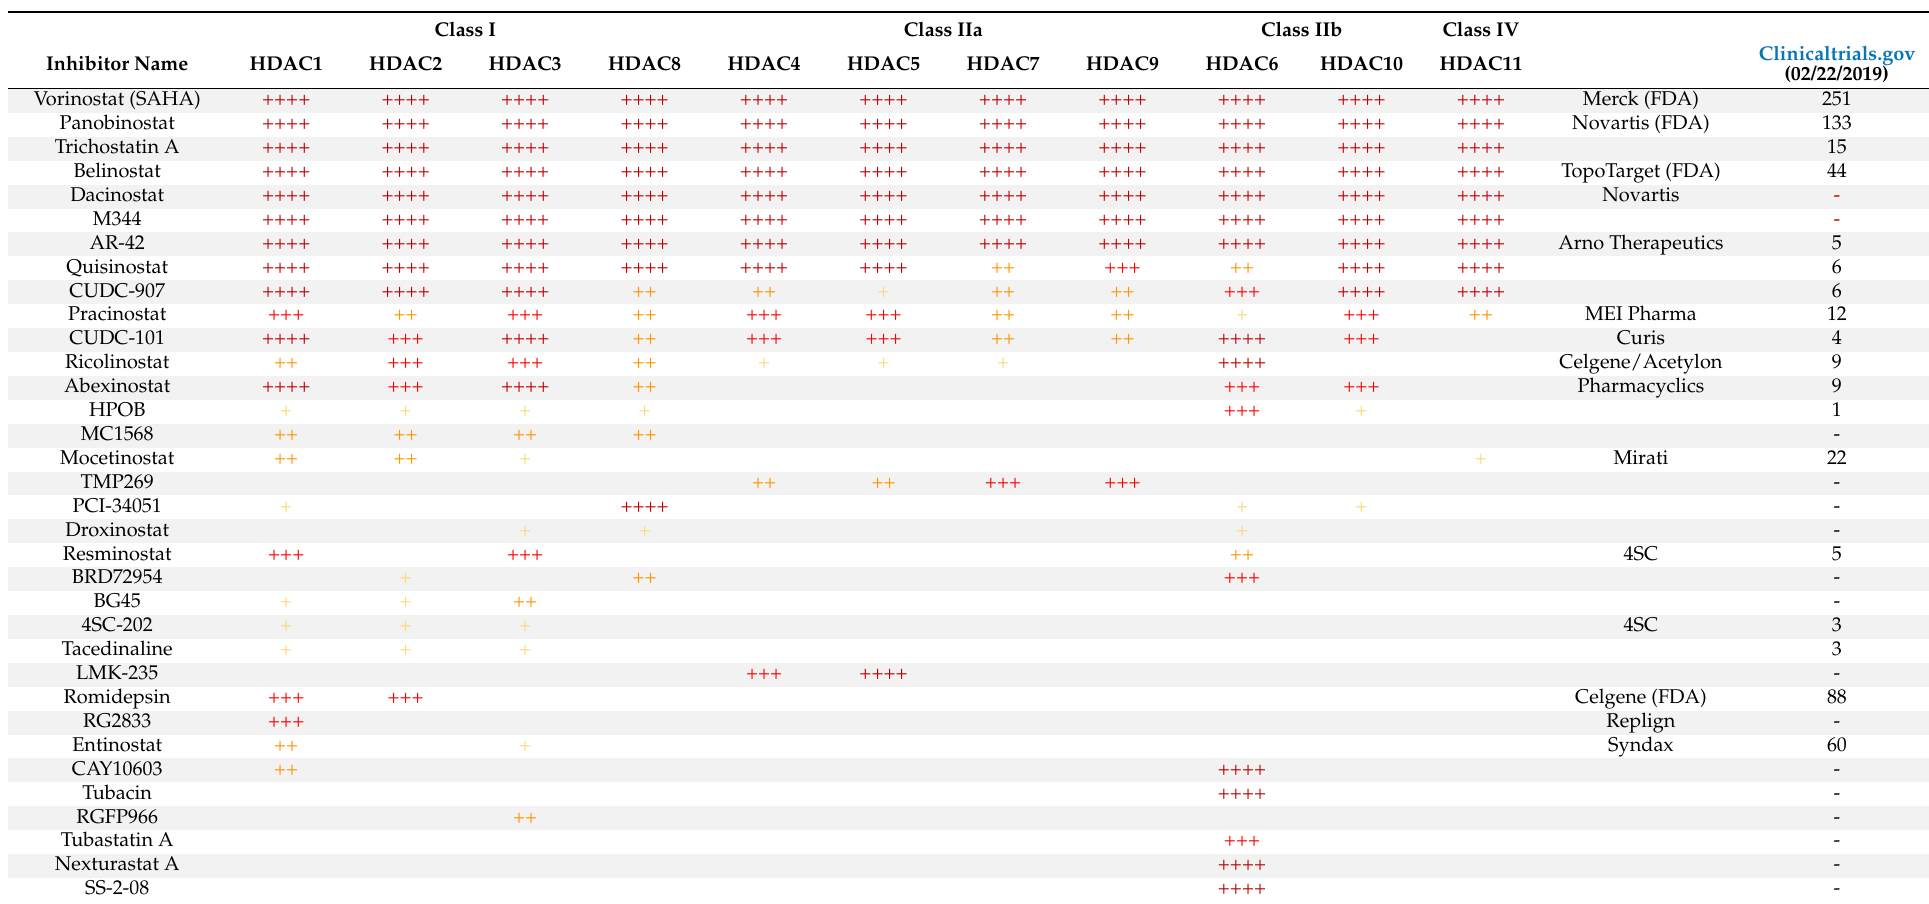
Table 3. Specificity and application of pan and selective HDACi. “+” indicates inhibitory selectivity. Additional “+” and red color indicate greater inhibitory effect. Modified from